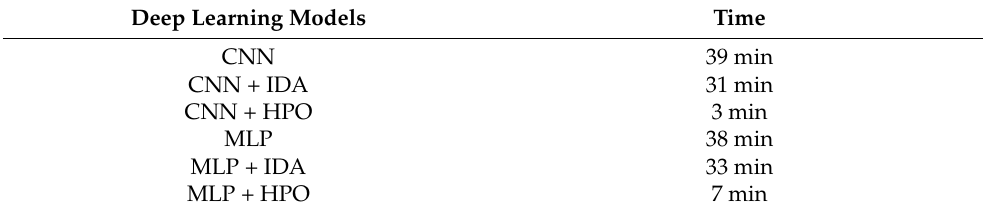
Table 11. Deep learning models with execution